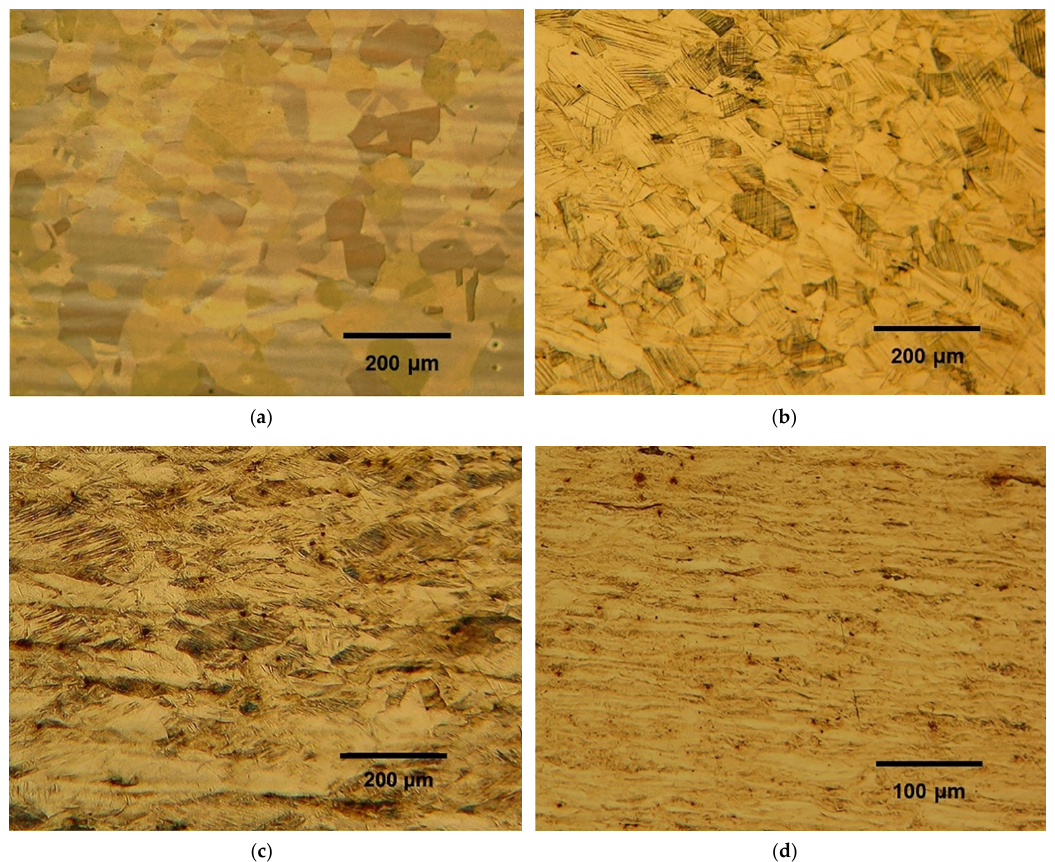
Figure 2. Microstructures of the Fe-0.5 C-21.5 Mn TWIP steel, cold rolled to reductions of ( a ) 0%, ( b ) 6%, ( c ) 31% and ( d ) 52%.